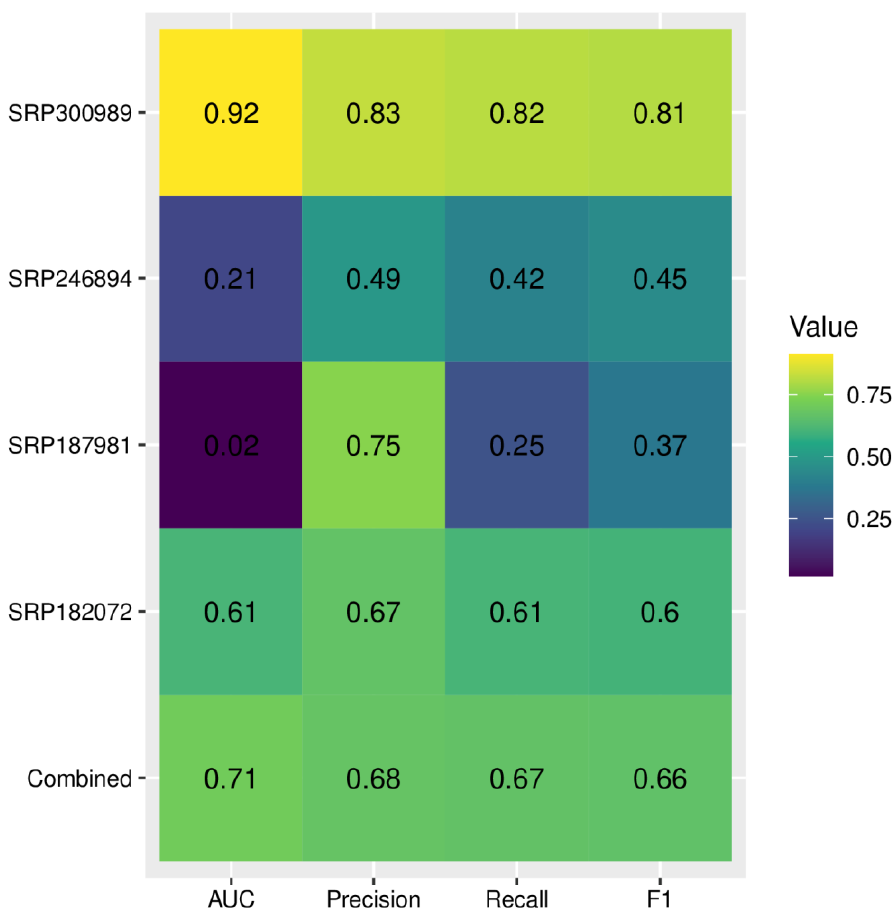
Figure 8. Accuracy of the deep learning model for microbiome-based differentiation between alcohol use disorder and healthy controls; AUC—area under the curve, F1—F1-score, harmonic mean of precision and recall. Larger values indicate better performance.